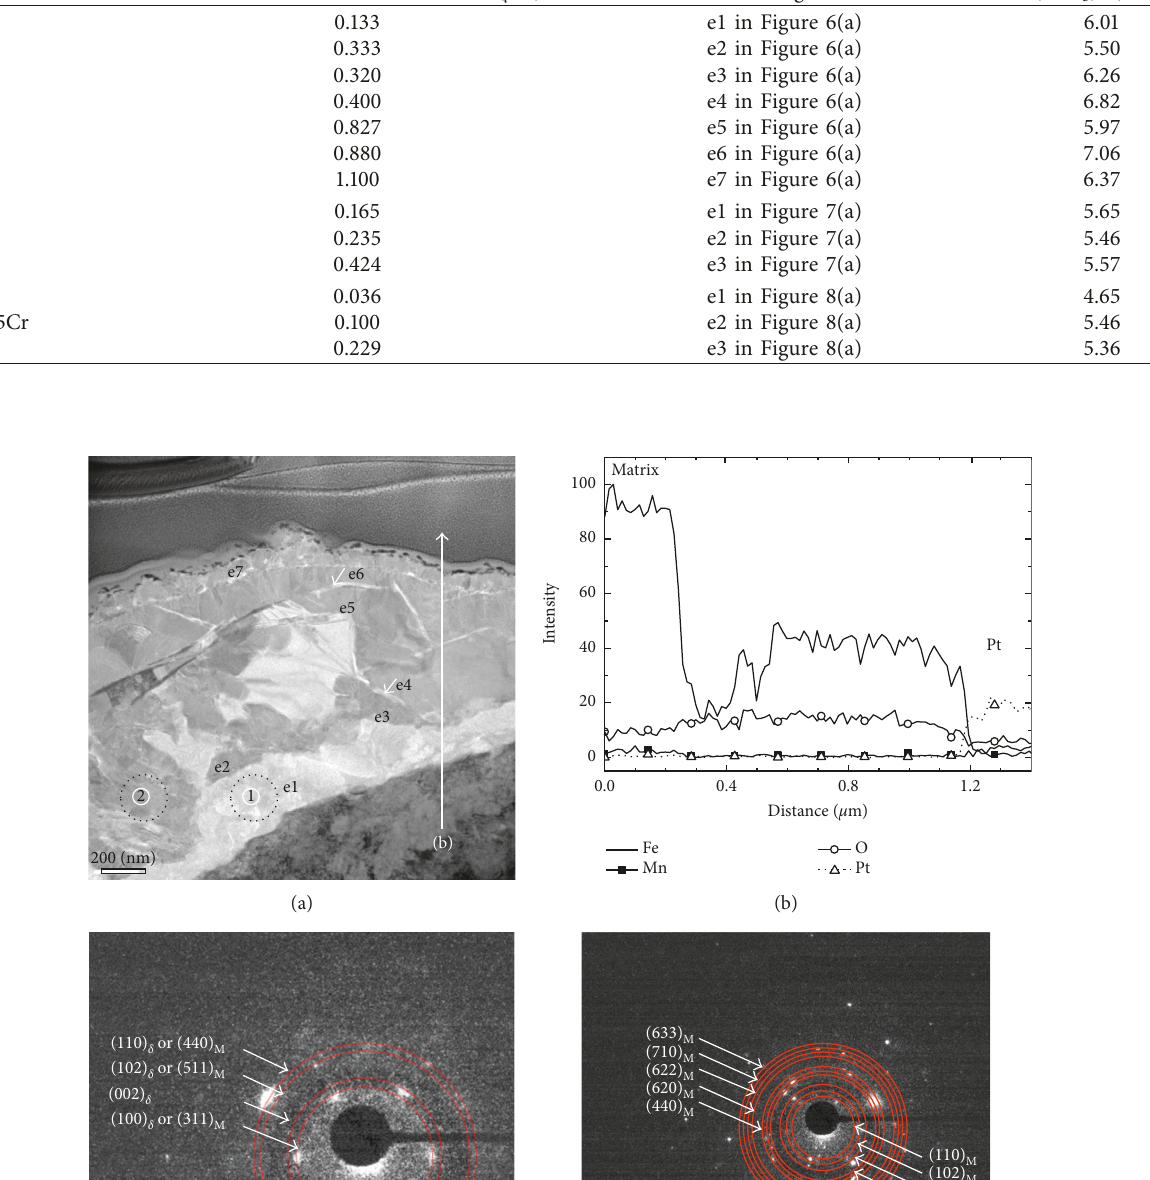
Table 6: Summary on the integral intensity ratio of Fe L REF, 18Mn, and 18Mn5Cr for 56 days in 3.5% NaCl solution at 60 o C. Alloy